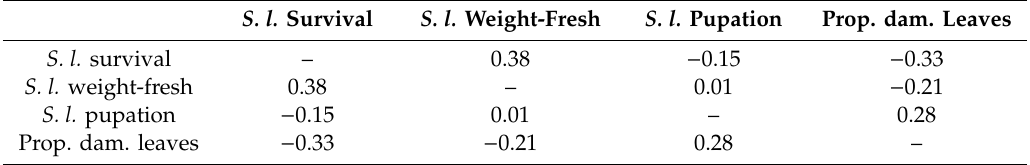
Table 1. Pair-wise correlation between the dependent variables used in the experiment, assessed using Spearman rank order correlations. None of the relationships are significant ( p > 0.05). The test was done at the level of single plant species, and thus, N =